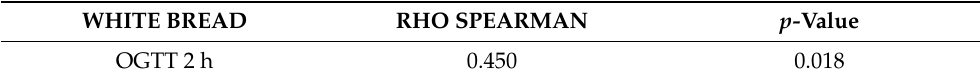
Table A8. Association between a consumption of white bread with glucose intolerance.